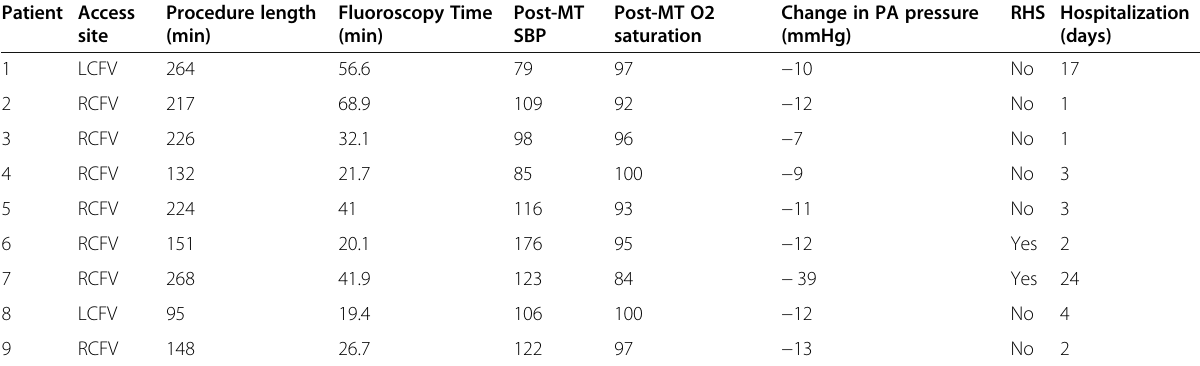
Table 2 Procedural details and mechanical thrombectomy outcomes Patient Access